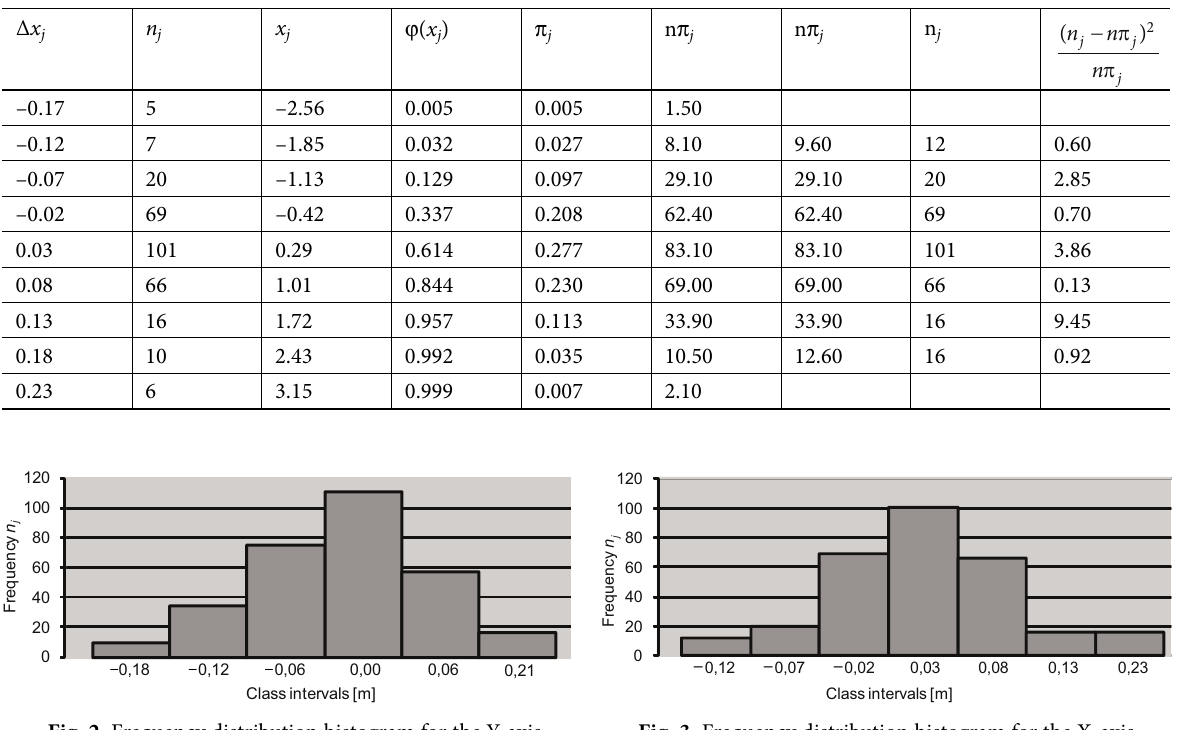
2 for the X coordinate axis (Přívoz cad. district)